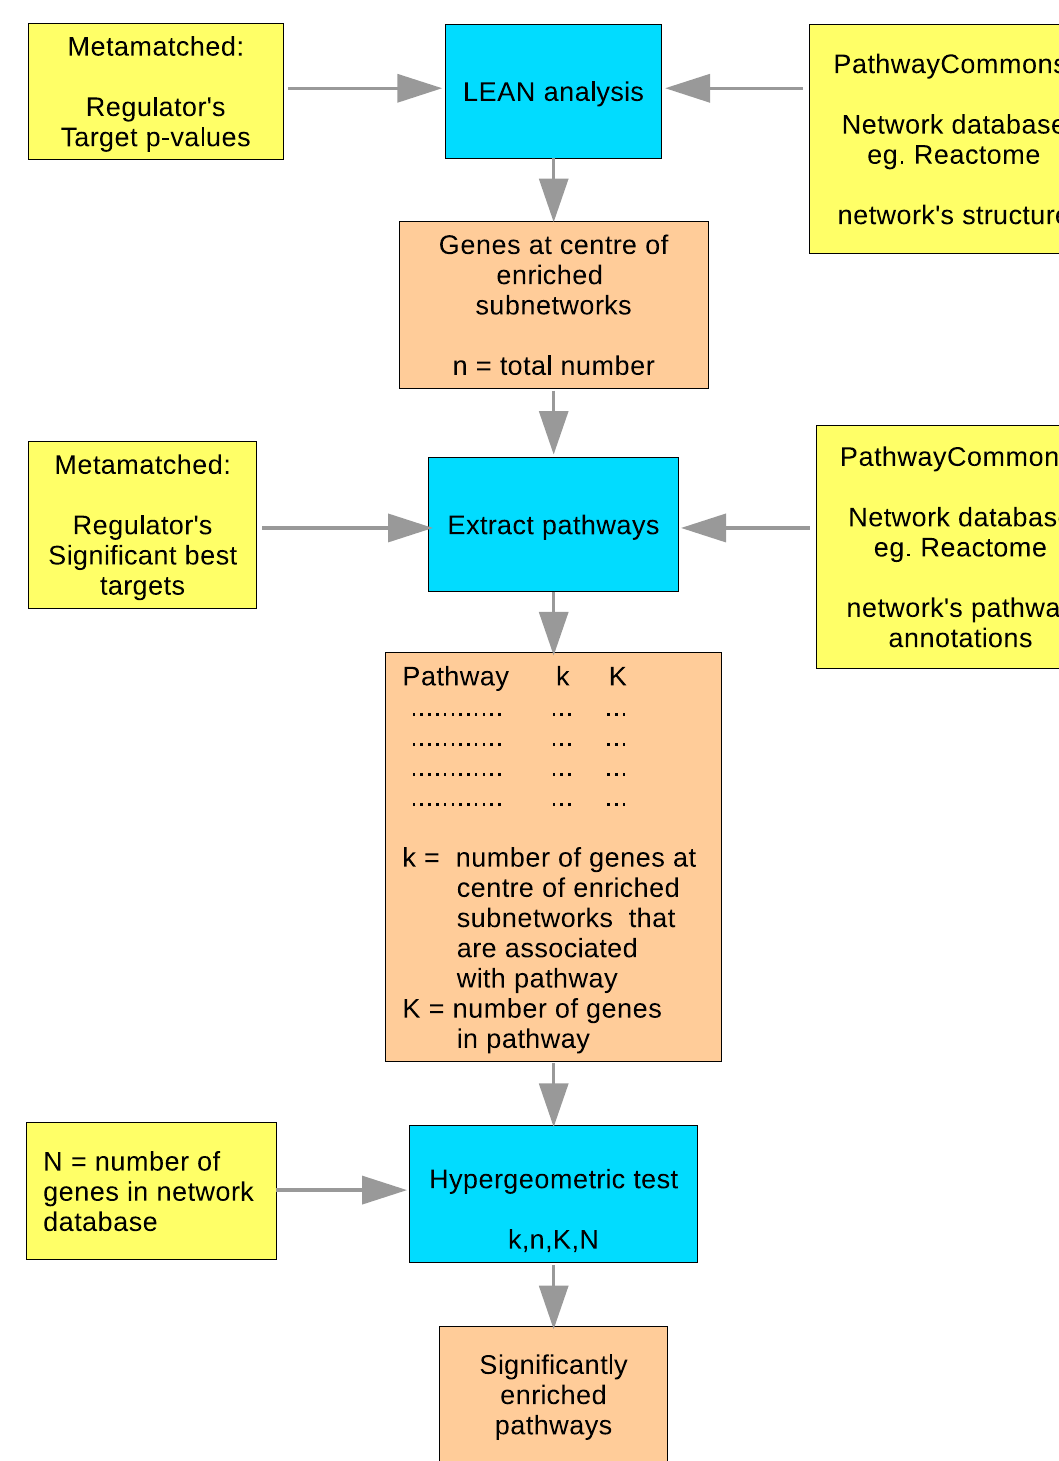
Fig 2. Schematic diagram showing the steps involved in the network-based pathway enrichment analysis.